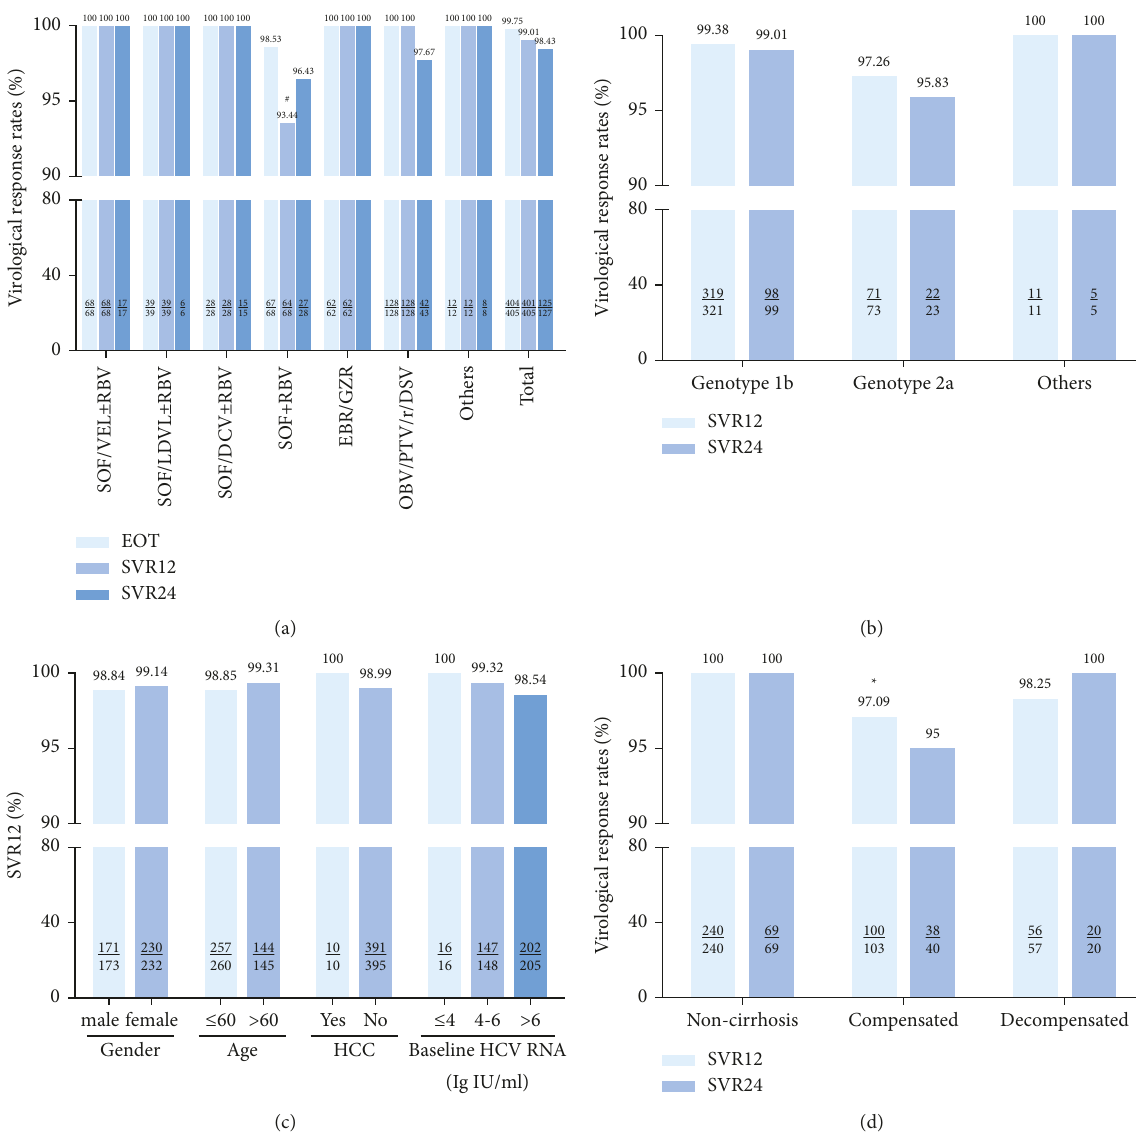
Figure 4: Virological response rates of EOT, SVR12, and SVR24 of DAA therapies in the real-world study. (a) Virological response rates of EOT, SVR12, and SVR24 in patients treated with different DAAs regimens. (b) SVR12 and SVR24 in patients with different HCV genotypes. (c) The SVR12 rates according to the most important baseline and on-treatment features. (d) The rates of SVR12 and SVR24 in patients with noncirrhosis, compensated, and decompensated cirrhosis. Categorical variables were compared using the χ 2 or the Fisher’s exact tests. EOT: end of treatment; SVR: sustained virological response. # SVR12 in OBV/PTV/r +DSV versus SOF+RBV, p SOF+RBV versus others, p 0 . 010; (cid:31) Table 5: Treatment response of different DAA regimens from 2018 to 2021.